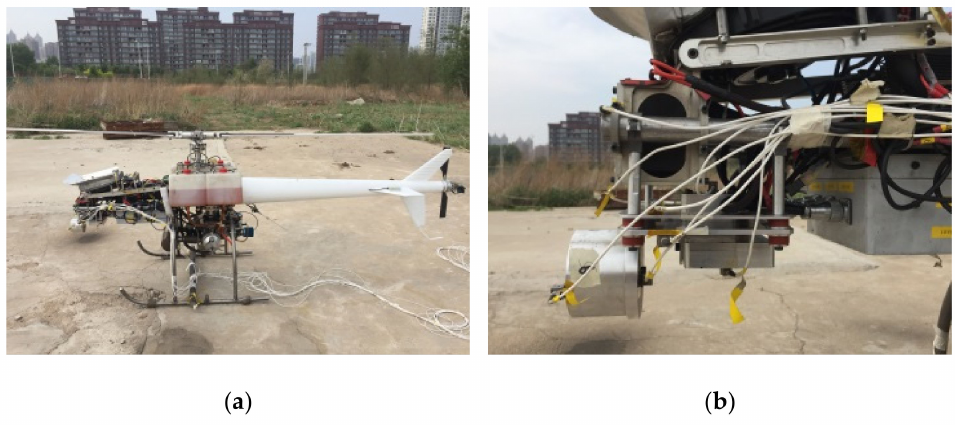
Figure 8. Installation location of a UAV LiDAR: ( a ) UAV; ( b )